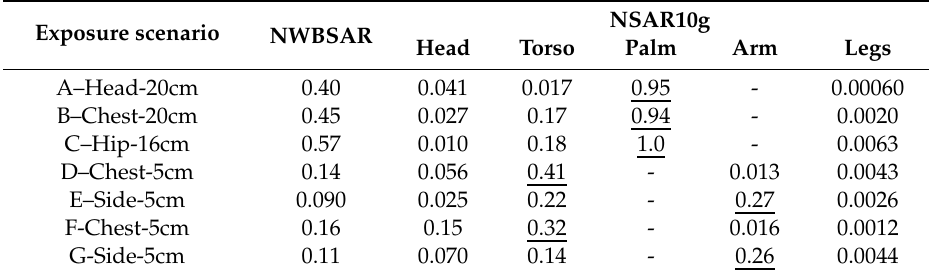
Table 2. Comparison of the whole body averaged and localized SAR under exposure to an EMF emitted by a modeled UHF RFID reader, at 1 W of radiated power and a frequency of 865 MHz (6-min continuous